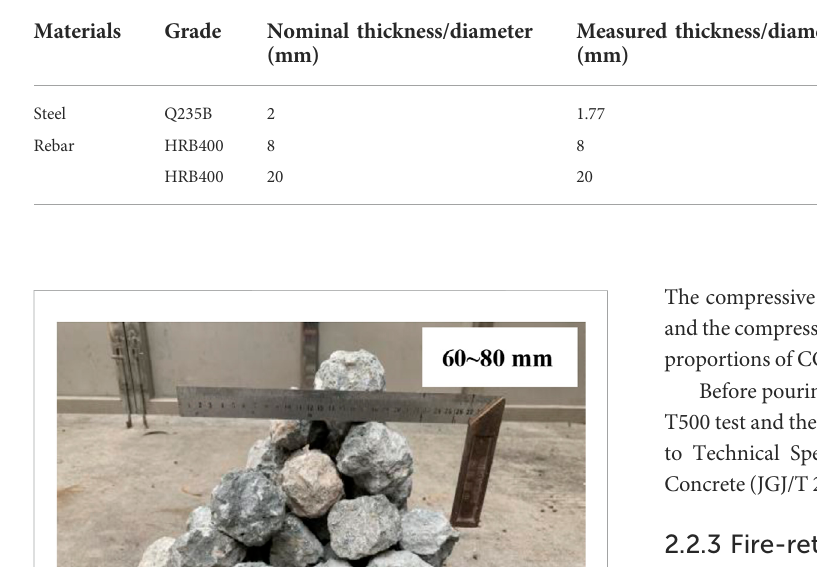
TABLE 2 Strengths of steel plate and steel bar.